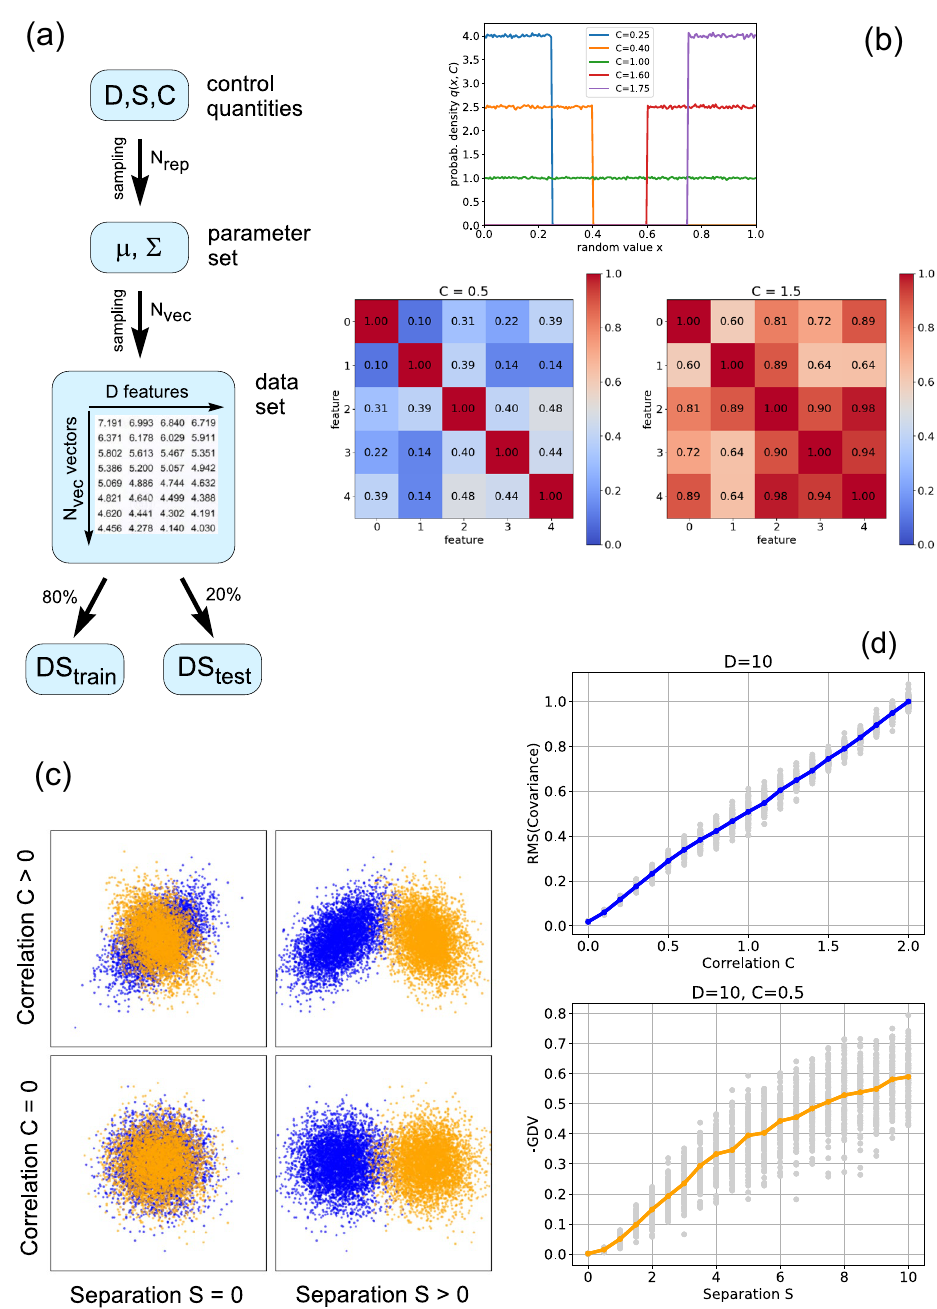
Figure 4. The superstatistical DSC model for generating artificial data with dimensionality D, a prescribed separation S between the classes, and feature correlations C within the classes. ( a ) Diagram depicting the hierarchical two-level structure of the model. For each triple of control quantities, N rep random parameter sets are generated. Then a data set of N vec vectors in D dimensions is sampled according to each parameter set. ( b ) The inter-feature correlations in each data set are described by covariance matrices (cid:31) ij , in which the level of correlations is controlled by the quantity C ∈ [ 0, 2 ] . The off-diagonal elements (cid:31) i = j are drawn from the C -dependent distribution q ( x , C ) shown in the top. Setting, for example, C = 0.5 , these elements range from 0 to 0.5 (lower left), and for C = 1.5 they range from 0.5 to 1 (lower right). ( c ) Visualization of the two data classes for a case with D=2 dimensions. The classes correspond to point clouds in feature space, where quantity S affects the distance between the means and quantity C affects the shape of the clouds. ( d ) When averaged over 100 independent data sets, the class separability (measured by the negative General Discrimination Value GDV) depends in a monotonous way on the separation quantity S. Similarly, the degree of inter-feature correlations (measured by the RMS of the off-diagonal co-variance matrix elements) is monotonically dependent on the correlation quantity